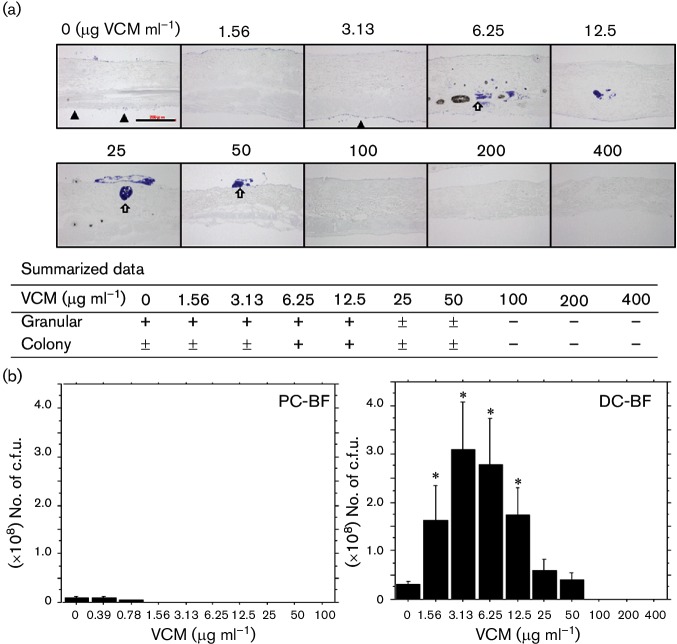
Distribution of OJ-1 in DC-BF exposed to VCM. (a) A granular pattern (indicated by arrowheads) and a colony-forming pattern (indicated by arrows) of bacterial distribution of OJ-1 were observed after 24 h incubation with VCM at different concentrations. The summarized data (n=5) are also shown. The extent of bacterial accumulation is indicated as follows: −, negative; ±, occasionally positive; +, frequently positive. Bar, 200 µm. (b) Histograms of c.f.u. values in PC-BF (left panel) and DC-BF (right panel) after exposure to different VCM concentrations. The data shown are mean values ± se. *, P<0.05.